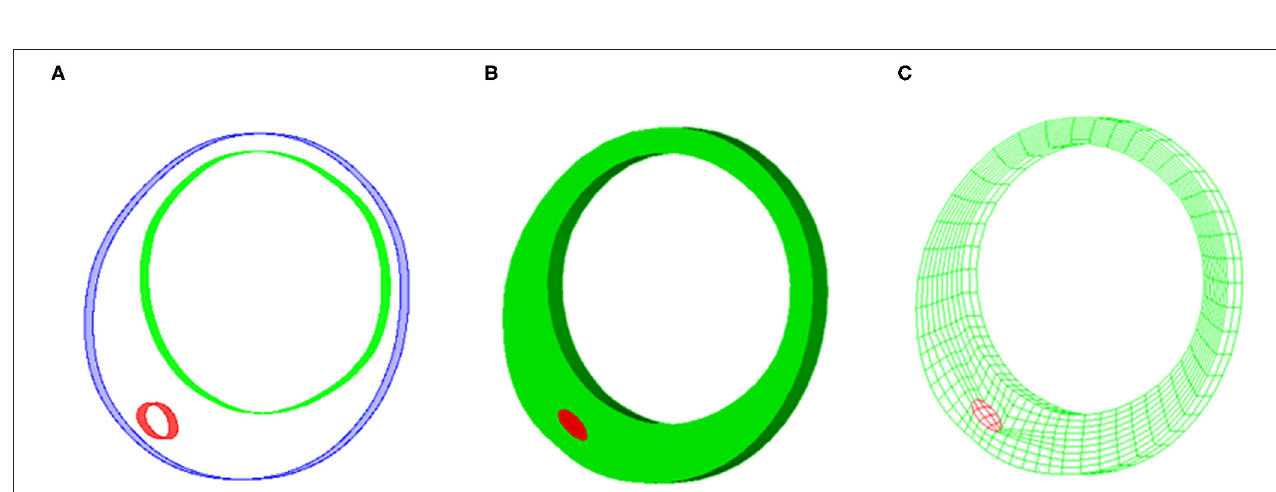
FIGURE 1 | (A) Virtual histology intravascular ultrasound (VH-IVUS) slice and its segmented contour showing the plaque components of one sample plaque; (B) matched IVUS slices with minimum lumen circumference (Cmin) and maximum lumen circumference (Cmax). Colors used in VH-IVUS: red, lipid rich necrotic core; dark green, fibrous; light green, fibro-fatty.